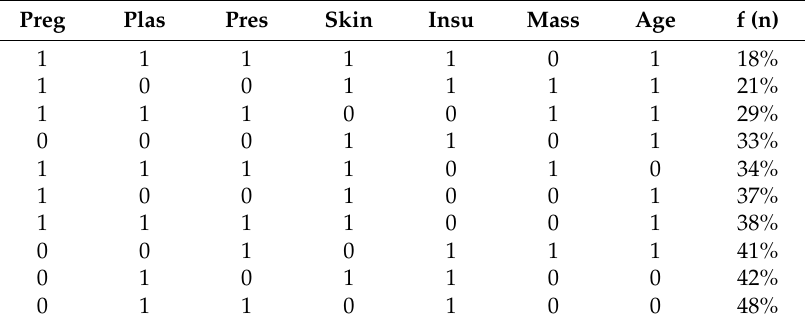
Table 14. Priority-based chromosome ranking based on Fitness Function. Preg Plas